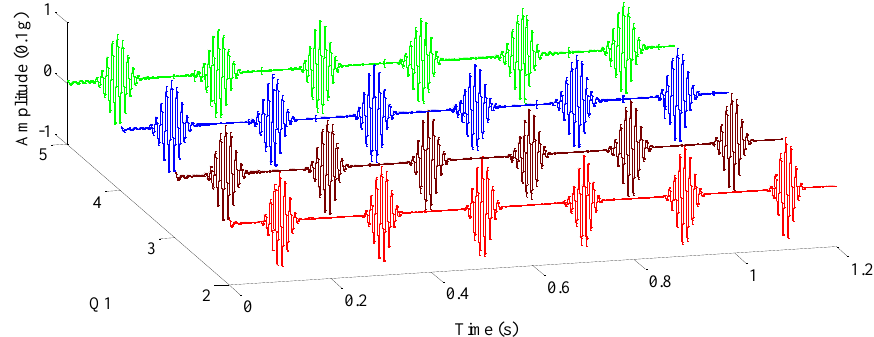
Figure 9. High-resonance components in cases where Q 1 = 2, 3, 4, 5.